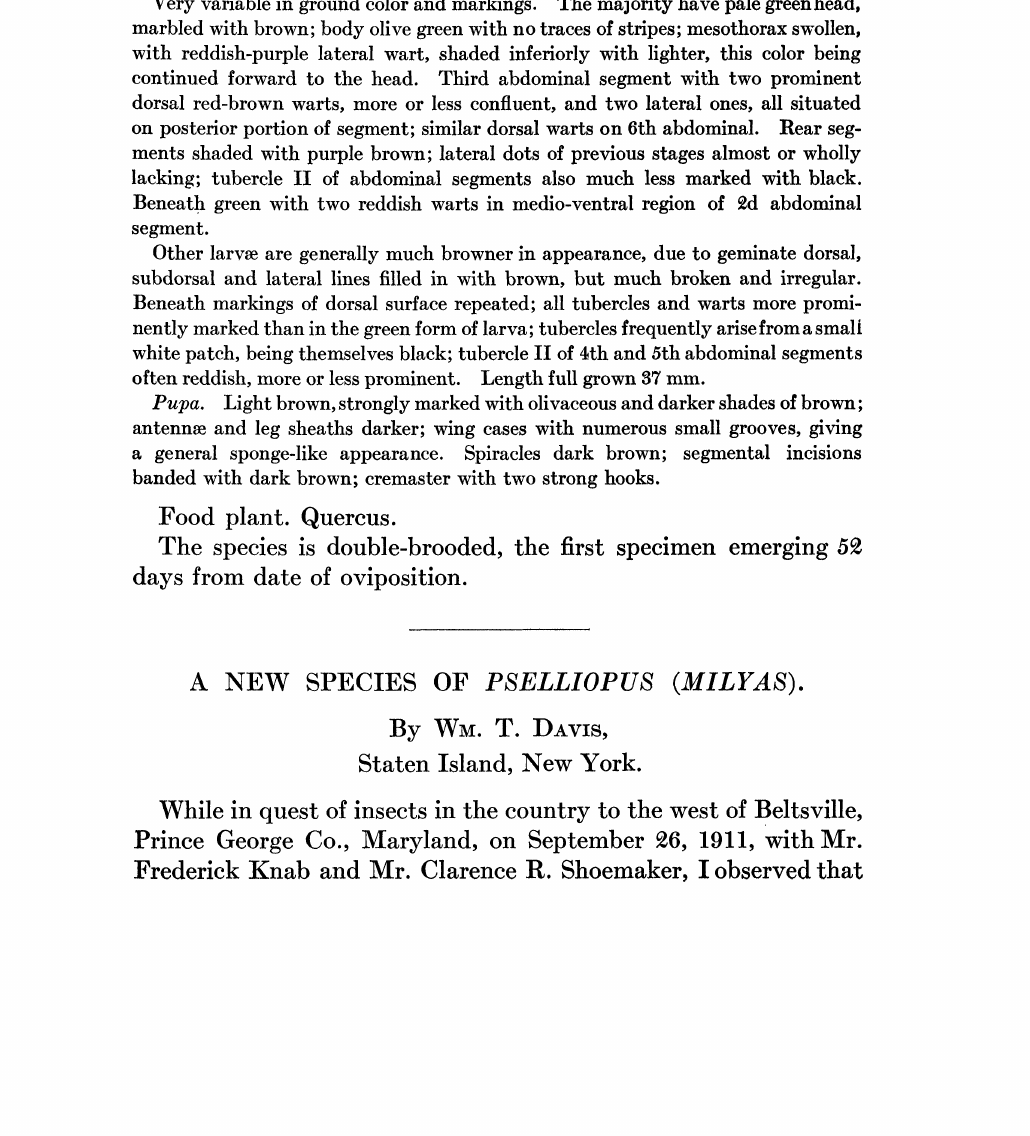
Psyche [February II on abdominal segments III, IV, V and I prominent, black. Beneath green with a pair of small black warts on the rear of abdominal segments. Length 16 ram. Stage IV. Head yellowish marbled with brown. Body green or yellow-green, in some cases much marbled with brown; lateral purple stripe prominent only on anterior and pos- terior segments where it is marbled with white; black lateral dots as before; black dorsal tubercles also present, especially prominent on abdominal segment III, where they form more or less raised warts; claspers striped with purplish, being the continuation of the lateral stripe. Two small black tubercles on posterior margin of segments underneath. Length 25 ram. Stage V. Very variable in ground color and markings. The majority have pale greenhead, marbled with brown; body olive green with no traces of stripes; mesothorax swollen, with reddish-purple lateral wart, shaded inferiorly with lighter, this color being continued forward to the head. Third abdominal segment with two prominent dorsal red-brown warts, more or less confluent, and two lateral ones, all situated on posterior portion of segment; similar dorsal warts on 6th abdominal. Rear seg- ments shaded with purple brown; lateral dots of previous stages almost or wholly lacking; tubercle II of abdominal segments also much less marked with black. Beneath green with two reddish warts in medio-ventral region of d abdominal segment. Other larvae are generally much browner in appearance, due to geminate dorsal, subdorsal and lateral lines filled in with brown, but much broken and irregular. Beneath markings of dorsal surface repeated; all tubercles and warts more promi- nently marked than in the green form of larva; tubercles frequently arisefroma small white patch, being themselves black; tubercle II of 4th and 5th abdominal segments often reddish, more or less prominent. Length full grown 87 mm. Pupa. Light brown, strongly marked with olivaceous and darker shades of brown; antennm and leg sheaths darker; wing cases with numerous small grooves, giving a general sponge-like appearance. Spiracles dark brown; segmental incisions banded with dark brown; cremaster with two strong hooks. Food plant.